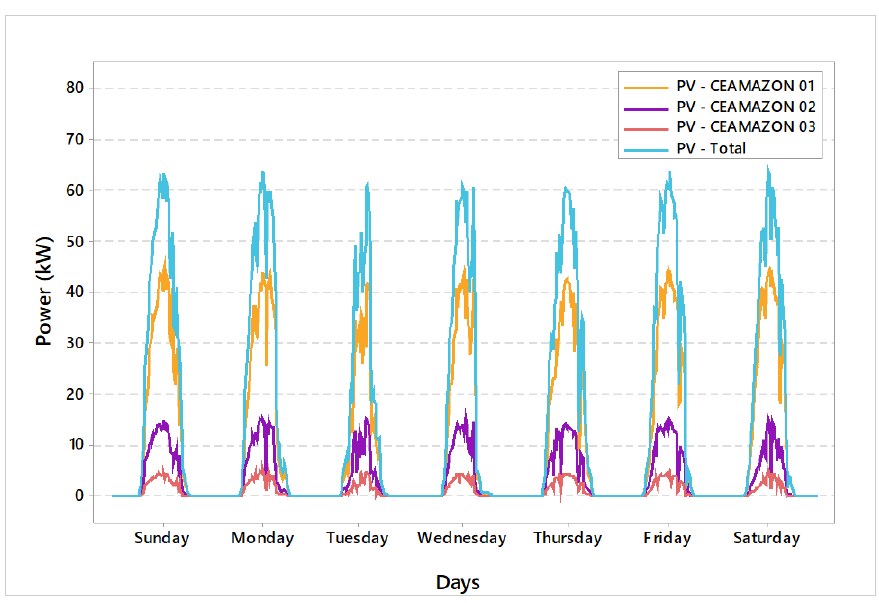
Figure 7. Total photovoltaic generation in the CEAMAZON mini power plant, within a week.